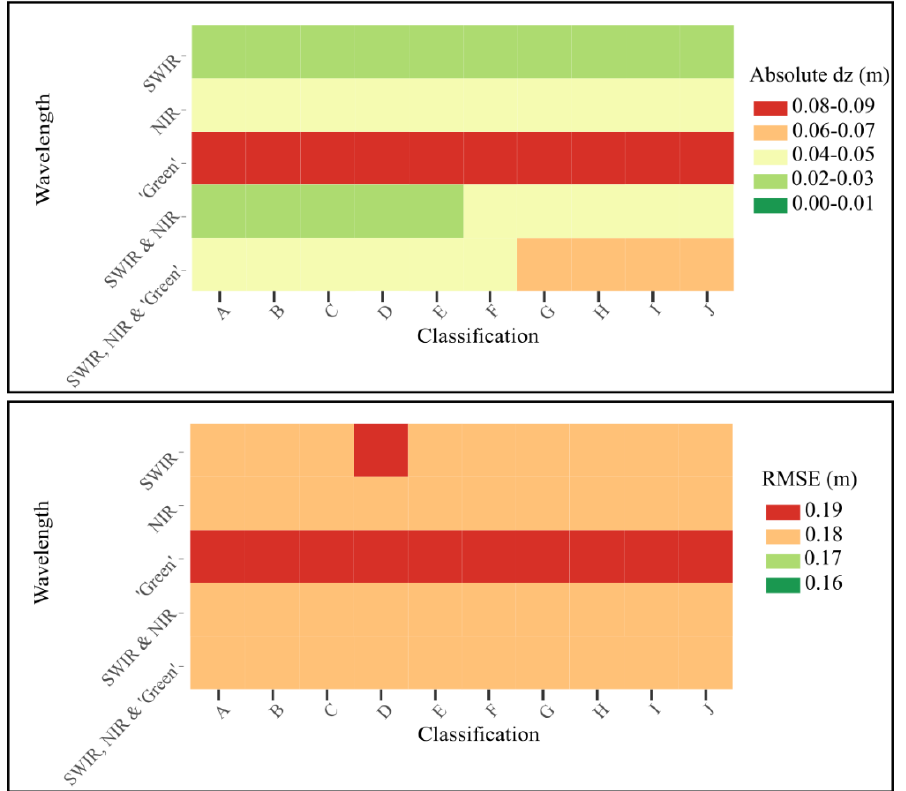
Figure 11. Ground classification results (| dz | and RMSE) in burned peatlands with tall vegetation regeneration two years post-fire (as a proxy for 3+ years post-fire). Classifications were conducted in LAStools.